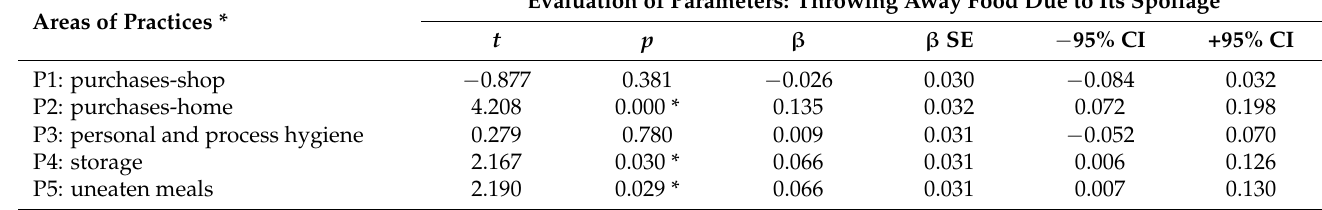
Table 7. The results of regression analysis showing relations between different areas of practices employed while dealing with food and throwing away food due to its